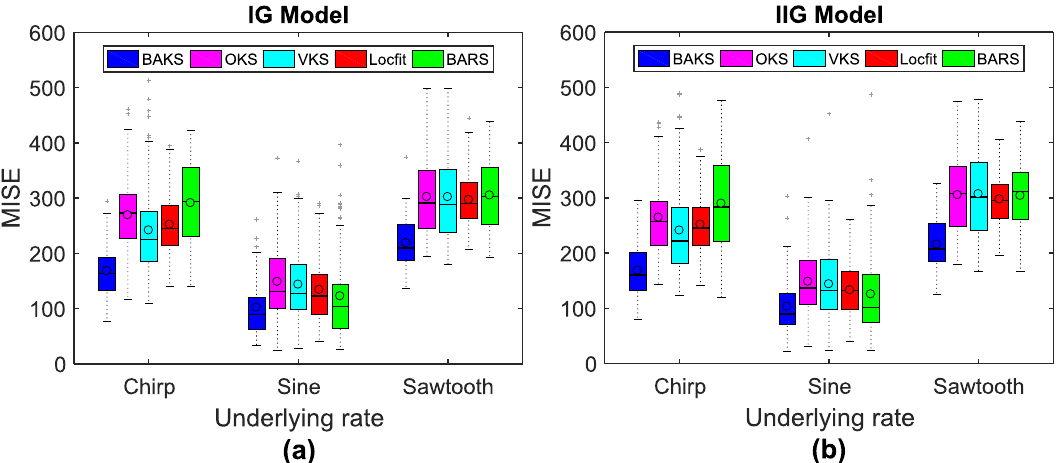
Fig 4. MISE comparison of BAKS with other methods. (a) MISE comparison for three rate functions (chirp, sine, and sawtooth) from IG model. (b) MISE comparison for three rate functions (chirp, sine, and sawtooth) from IIG model. In each boxplot, black lines show the medians; black circles indicate the means; colored solid boxes represent interquartile ranges; whiskers extend 1.5 × from upper and lower quartiles; gray crosses represent